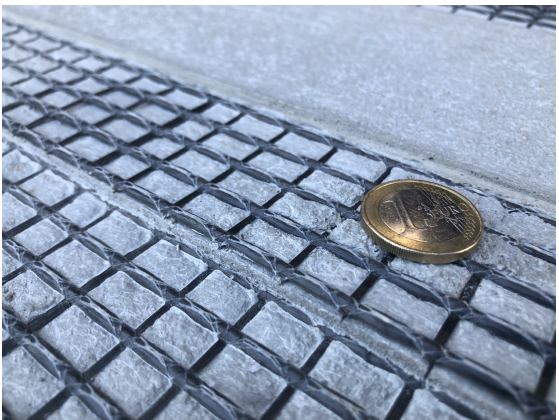
Figure 1. Mesostructural setup of textile reinforced